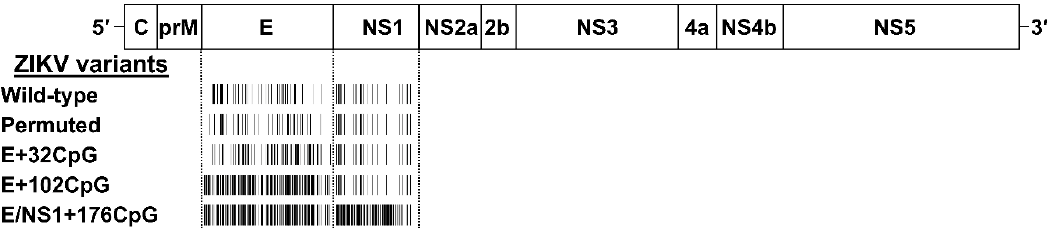
Figure 1. The genome of Zika virus (ZIKV) and the CpG (cytosine–phosphate–guanine)-recoding strategy. ZIKV genomic regions encoding envelope (E) and non-structural 1 (NS1) proteins were